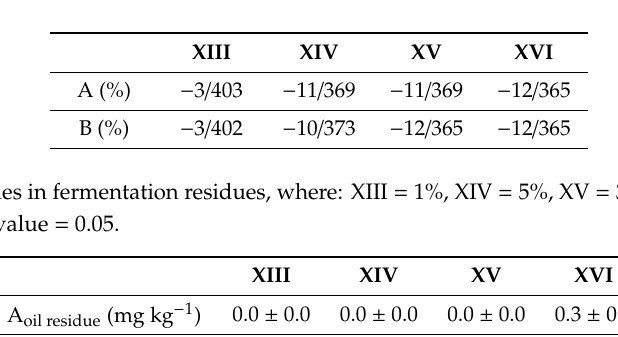
Table 7. Dynamics of methane production, where: XIII = 1%, XIV = 5%, XV = 30% and XVI = 100% emulsion level. Results are expressed as % change in comparison to blank sample (water only = 100%) / hours.